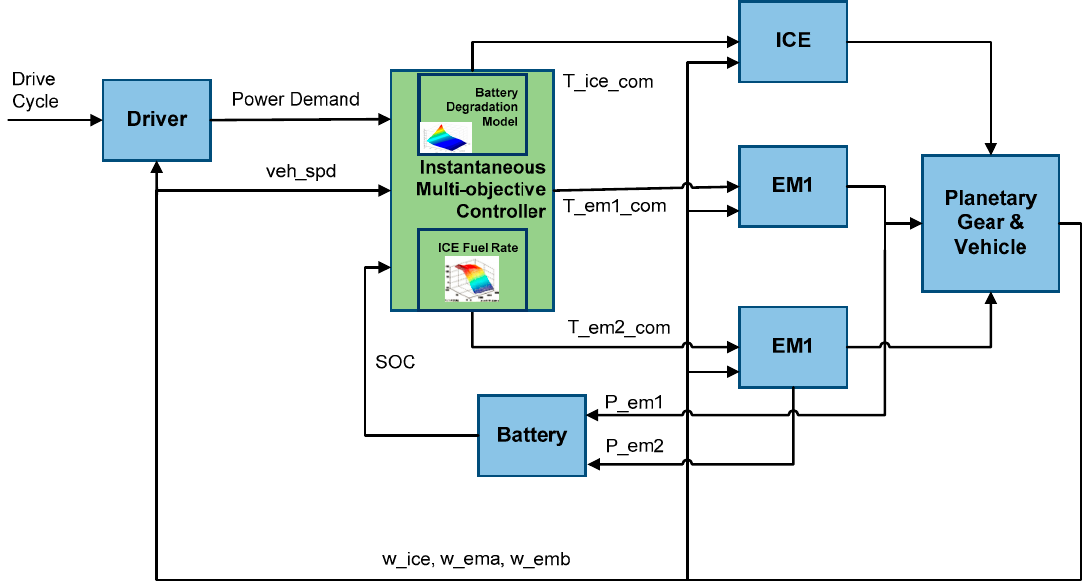
Figure 4. Instantaneous battery health-conscious optimal control-oriented framework.